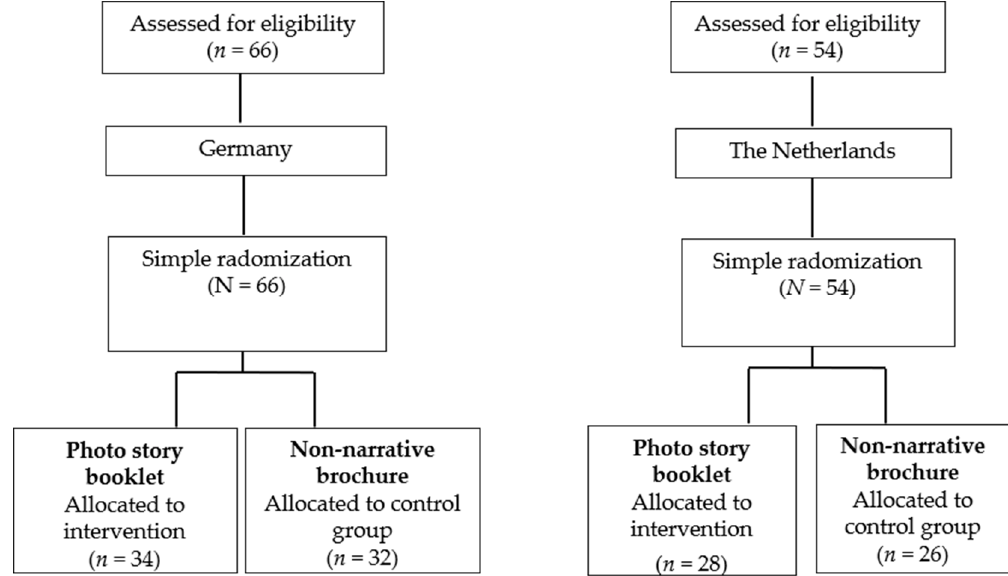
Figure 1. Flow of Randomized Controlled Trials (RCT) participants in Germany and the Netherlands.